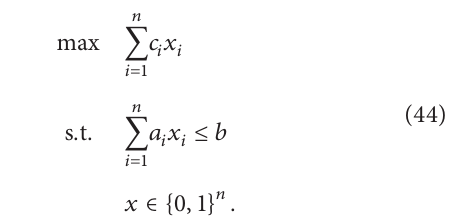
Algorithm 24 (algorithm to obtain certificate of optimality for